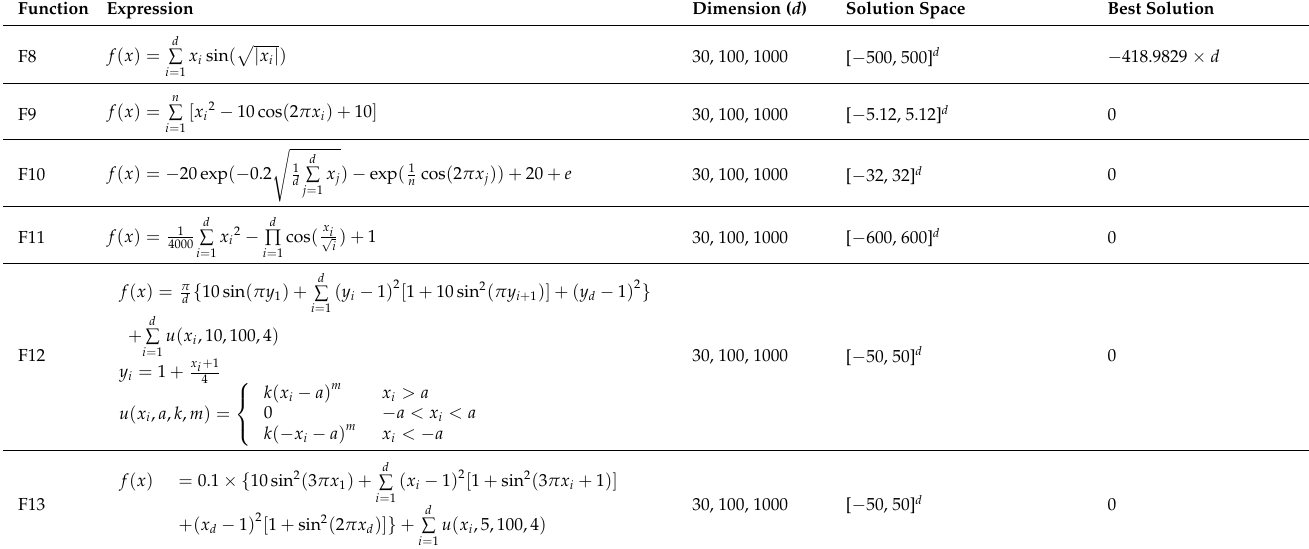
Table 3. Multimodal standard famous functions.